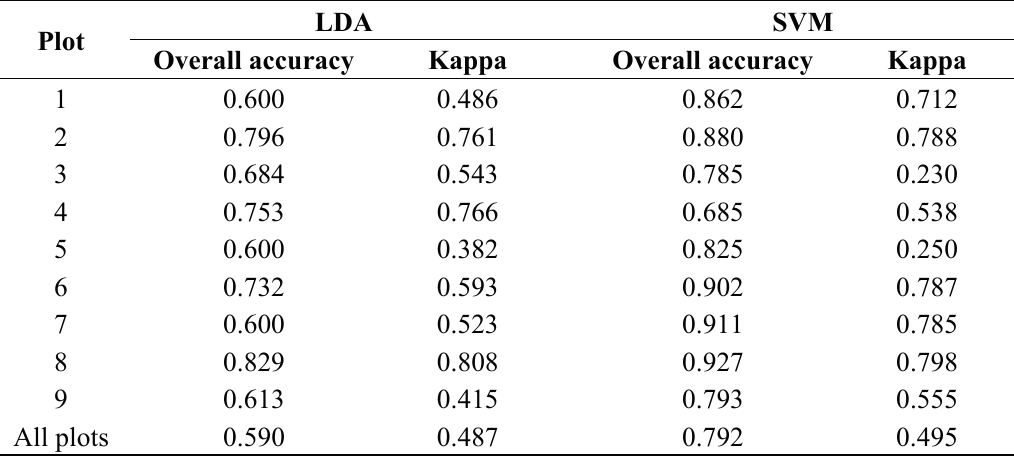
Table 9. Overall accuracy and kappa obtained from the linear discriminant analysis (LDA) and the support vector machine (SVM) classification methods to detect Verticillium wilt severity levels for the individual olive plots assessed and for the all the plots together.